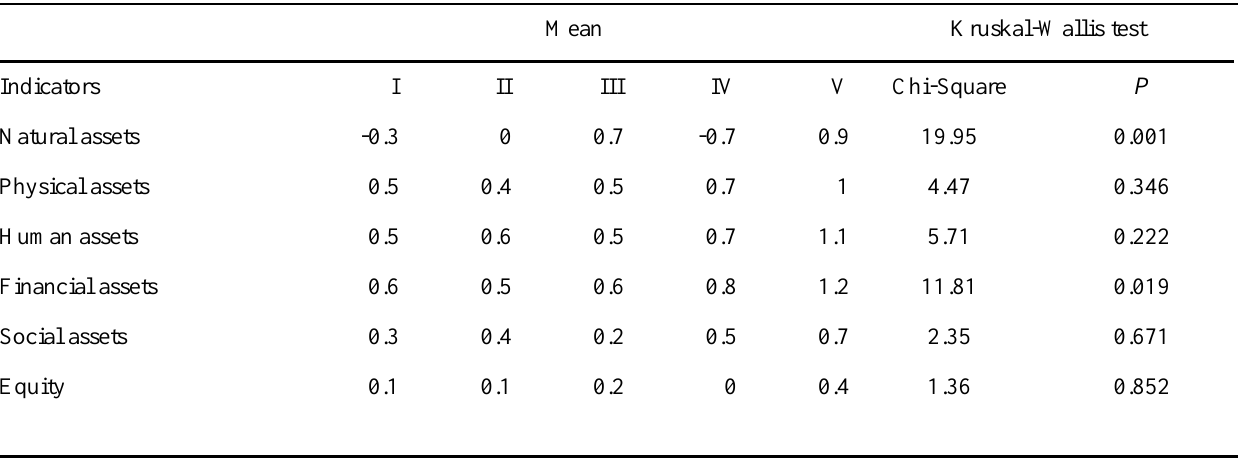
Table 5. Mean aggregate livelihood outcomes per household strategy. I = Subsistence; II = Supplementary; III = Integrated; IV = Specialized extraction; V = Specialized